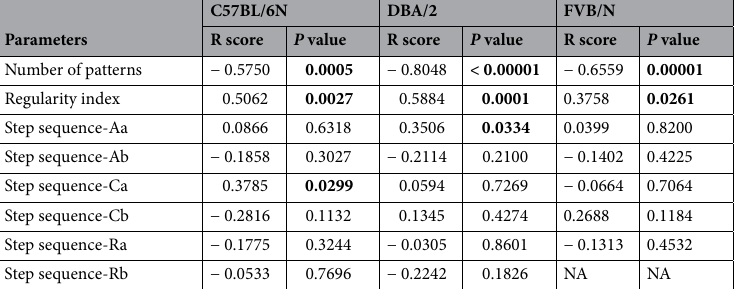
Table 2. Correlation between the speed and gait parameters. The correlation was measured using Pearson’s correlation coefficient for each strain. The bold values indicate significant results.